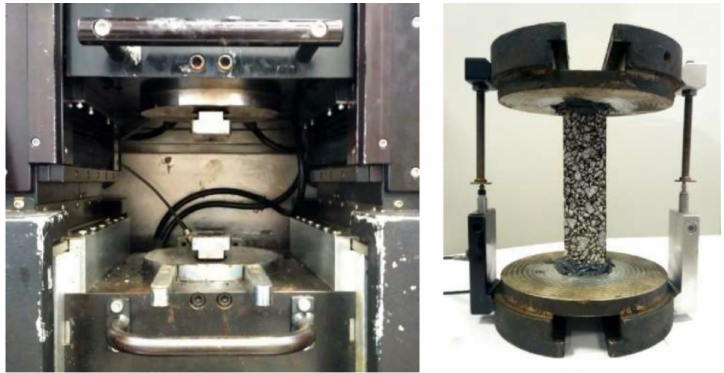
Figure 3. Testing apparatus and specimen ready for